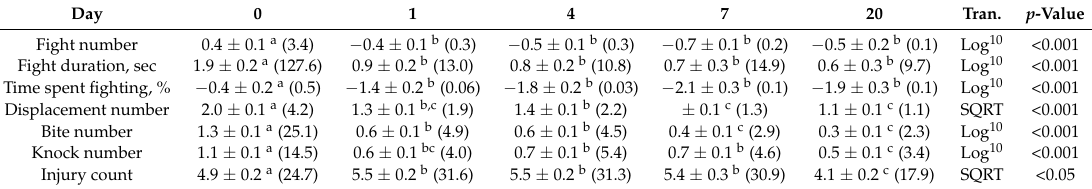
Table 2. The effect of day after the mixing event on parameters linked to aggression, including different behaviors and injury counts per sow in sows housed in groups of 12 from the day of mixing to day 20 following mixing * ,1